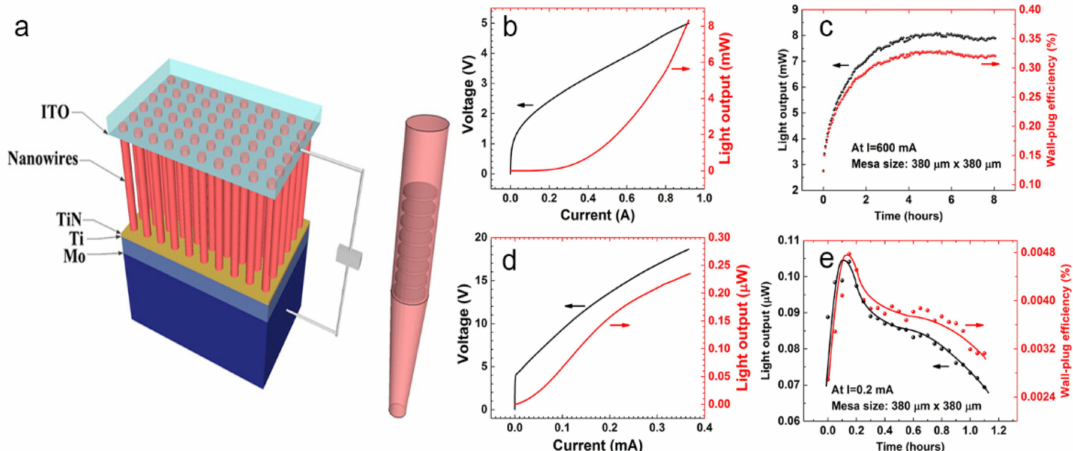
Figure 16. ( a ) Schematic of the LED structure grown on Mo substrate. ( b ) and ( d ) Light output power − current − voltage (L–I–V) curves of LEDs on Mo substrate and Si substrate, respectively. ( c ) and ( e ) Light output power and wall-plug efficiency of LEDs on Mo substrate and Si substrate, respectively. Reproduced from [143], with permission from Copyright American Chemical Society,